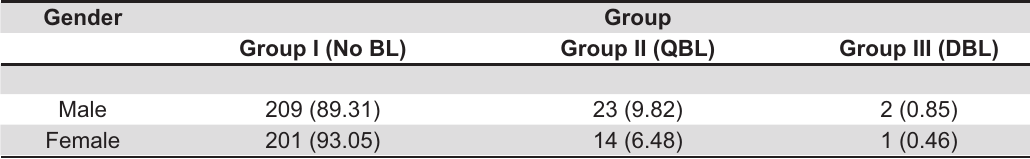
Table 2- Bone Loss (BL) according to gender